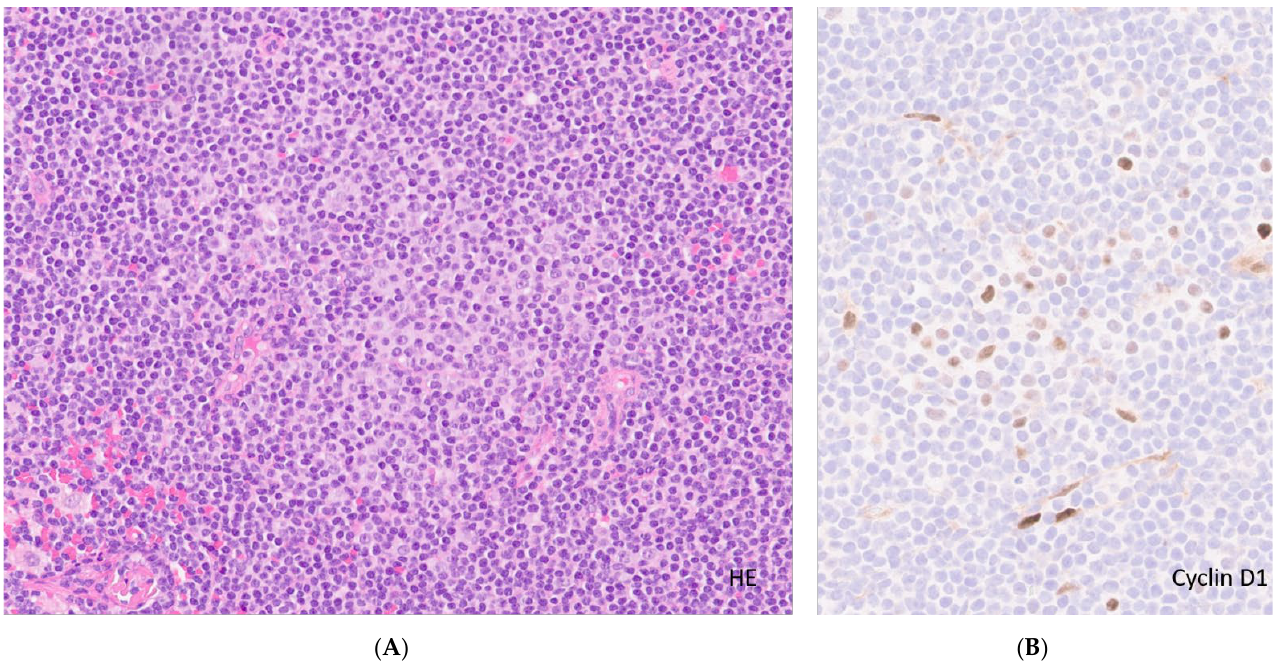
Figure 1 . Lymph involved by CLL. ( A ). Lymph node involved in CLL. Effacement of lymph node architecture by neoplastic cells (H&E, original magnification ×10) highlighting a proliferation center (pale area with prolymphocytes/paraimmunoblasts) in the center; ( B ). High-power view of the proliferation center with a few large cells positive for Cyclin D1, (original magnification ×20) contrary to MCL (uniform strong nuclear expression in most cases).